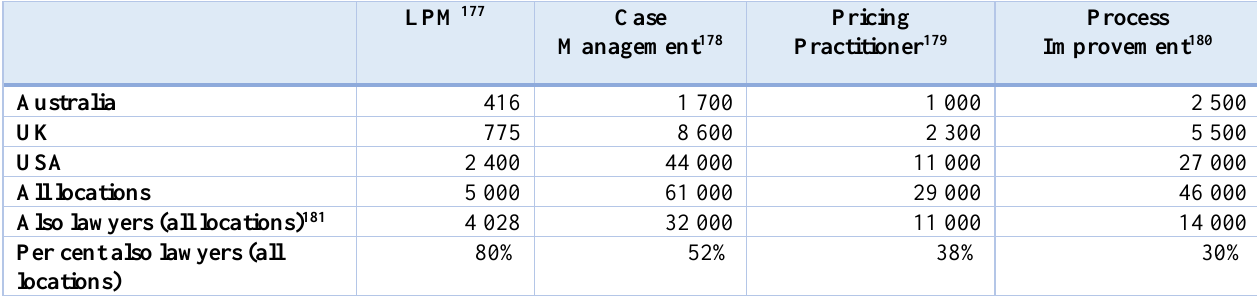
Table 2. The Number of LPM Practitioners in Law Practice and Legal Services on LinkedIn, 2020 LPM 177 Case Management